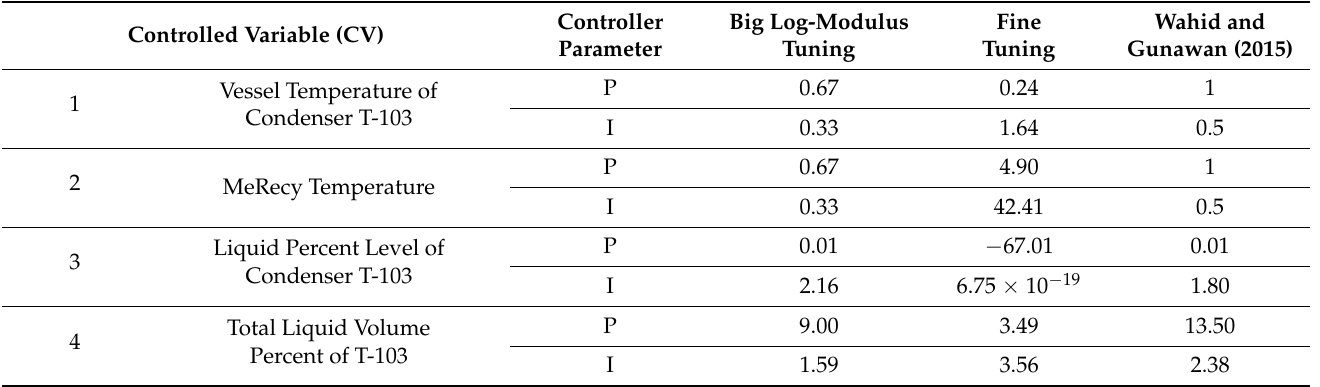
Table 8. Proportional integral (PI) controller parameters of the methanol purification process.